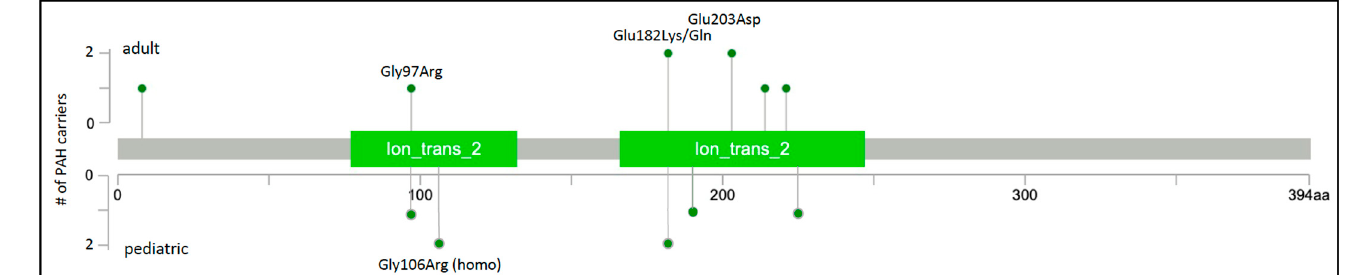
Figure 3. KCNK3 two-dimensional protein schematic. Variants identified in adult-onset PAH cases are shown above the protein schematic; variants identified in children are shown below. All variants are missense. The number of PAH carriers identified with a particular variant is shown along the y -axis. Conserved protein domains are indicated by colored rectangles. Ion_trans_2, ion channel. Map generated using MutationMapper at cBioPortal.org, accessed on 2 January